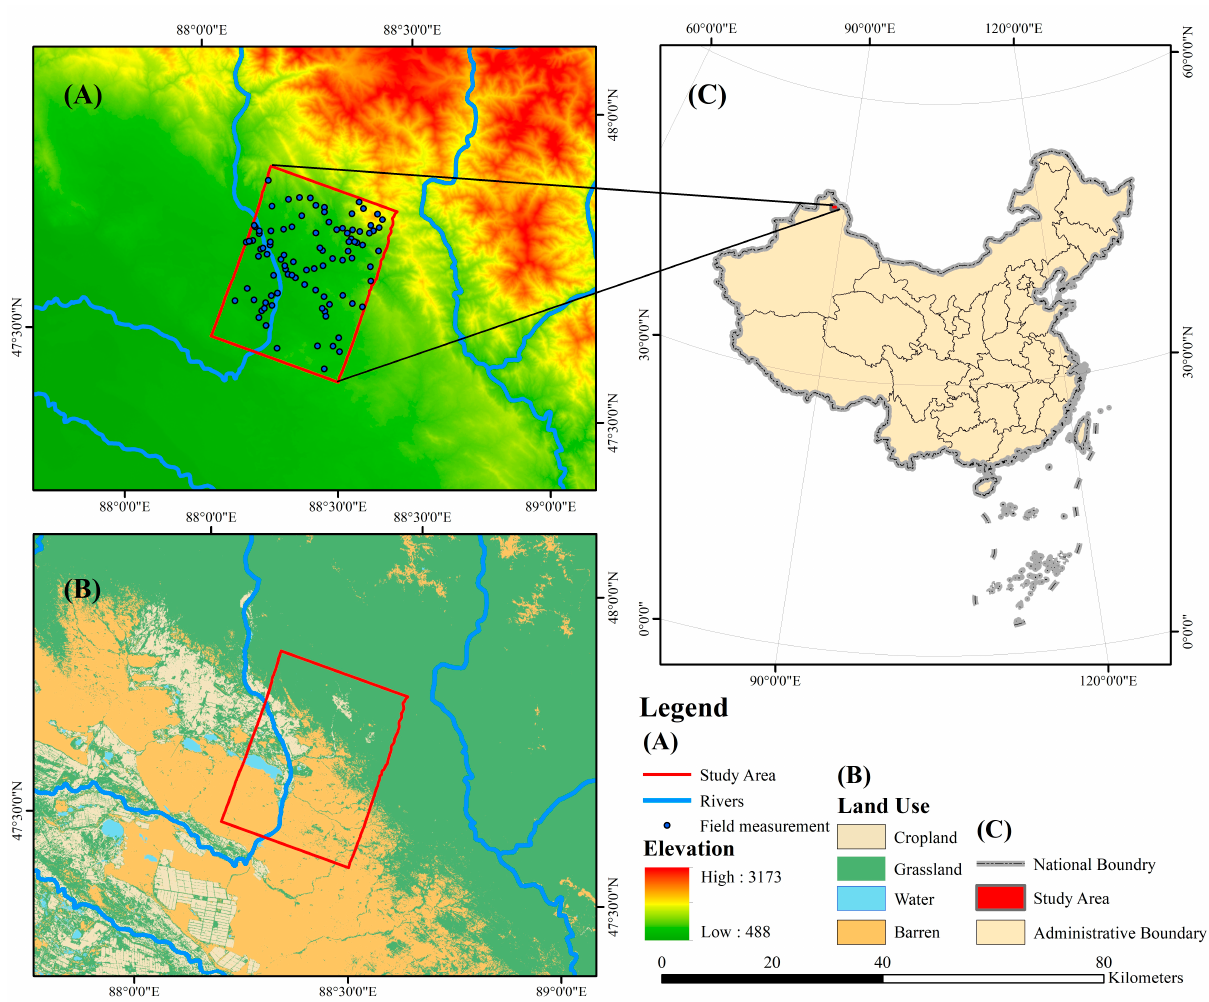
Figure 1. ( A ) shows the topography of the study area and the location of measurement points; ( B ) shows the land use types in the study area and ( C ) shows the location of the study area in China.